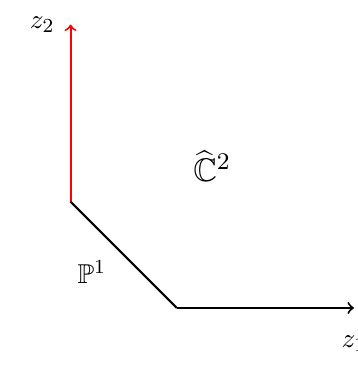
Figure 4 . A surface defect on the ordinary C 2 and the blowup b C 2 . The surface defect is extended along the non-compact z 1 -plane, drawn in the red line. On the blowup b C 2 , the surface defect is attached to the south pole of the exceptional divisor P 1